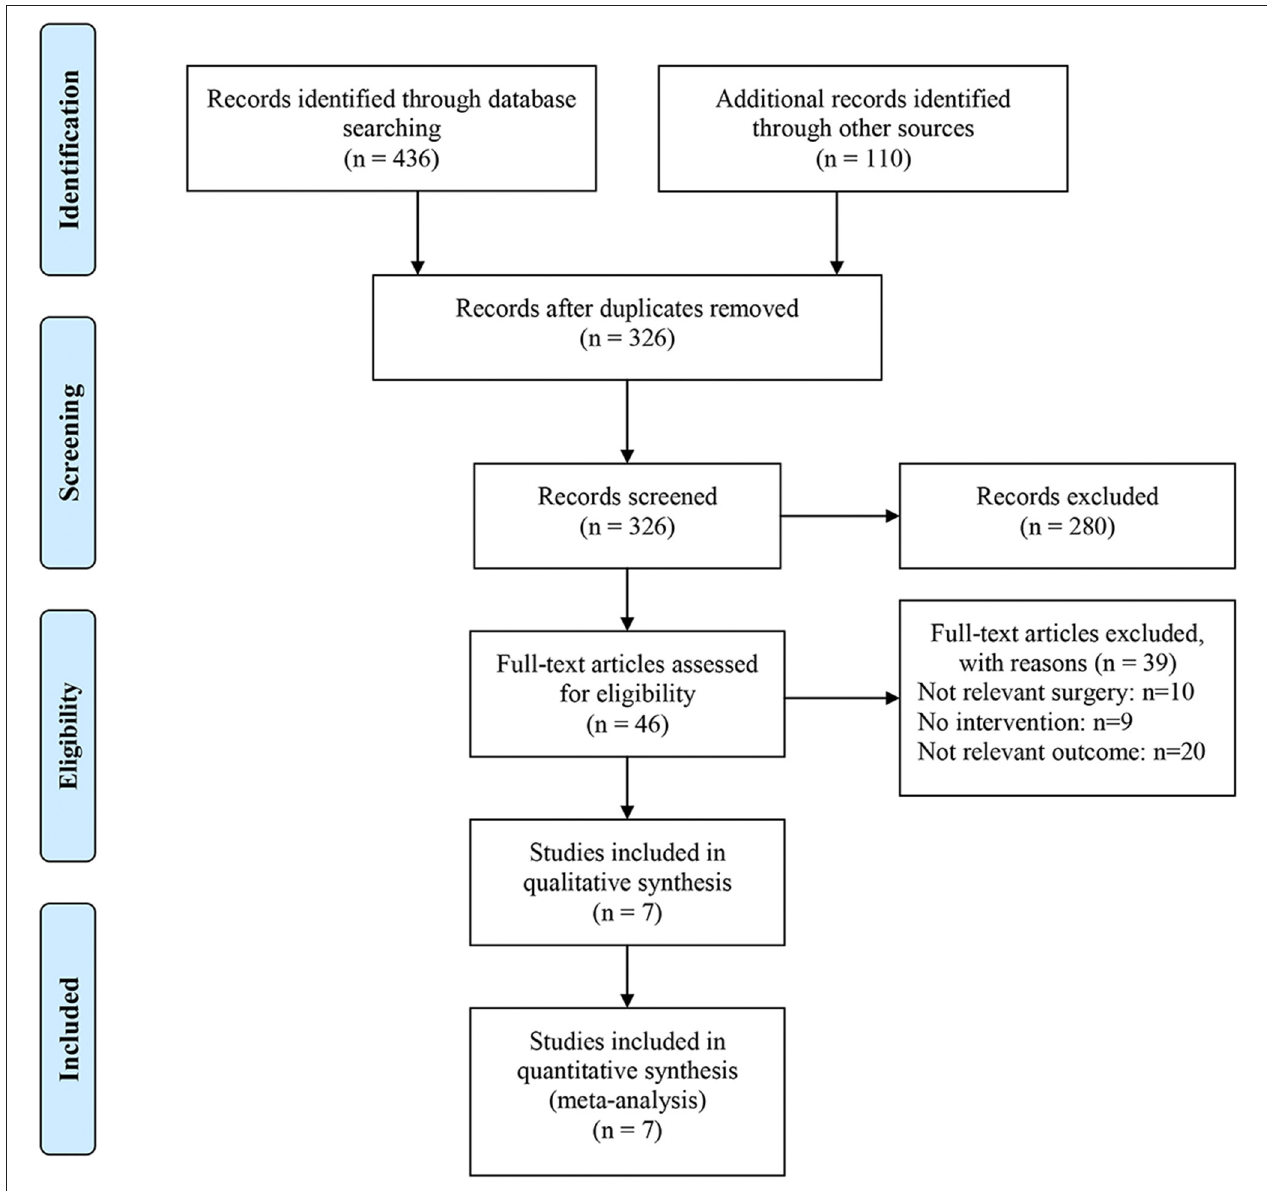
FIGURE 1 | Flow chart of studies identified and included in the current